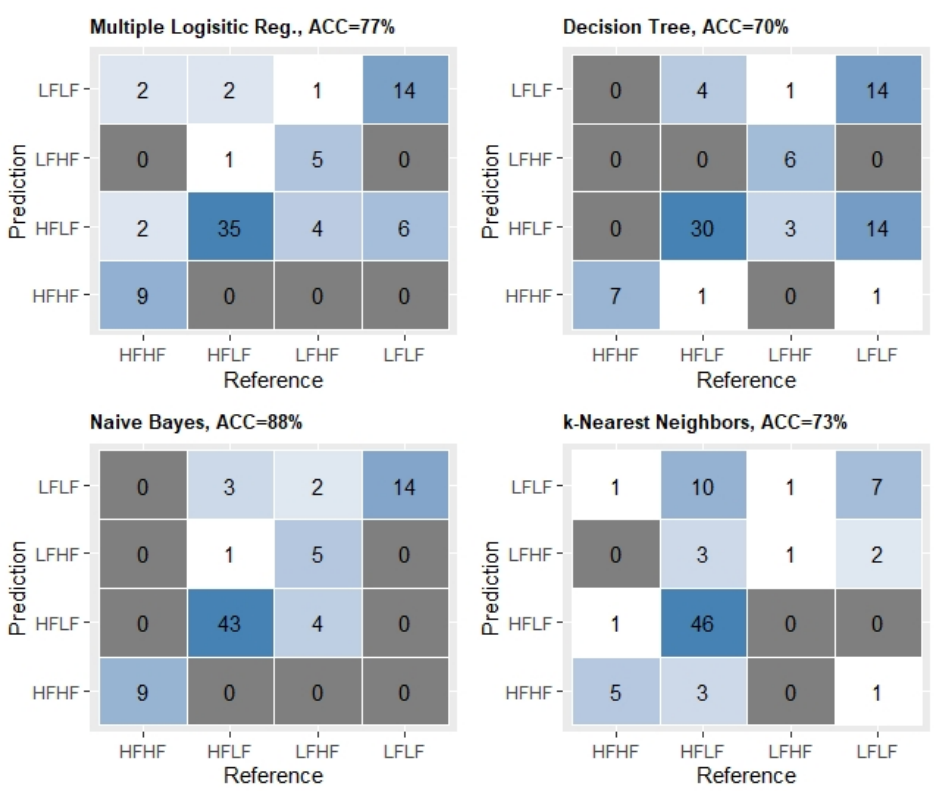
Figure 4. Confusion Matrices, and accuracy of the four classification models. ACC = accuracy, HFHF = Higher-Fatness with Higher-Fitness group, HFLF = Higher-Fatness with Lower-Fitness group, LFHF = Lower-Fatness with Higher-Fitness group, LFLF = Lower-Fatness with Lower -Fitness group.